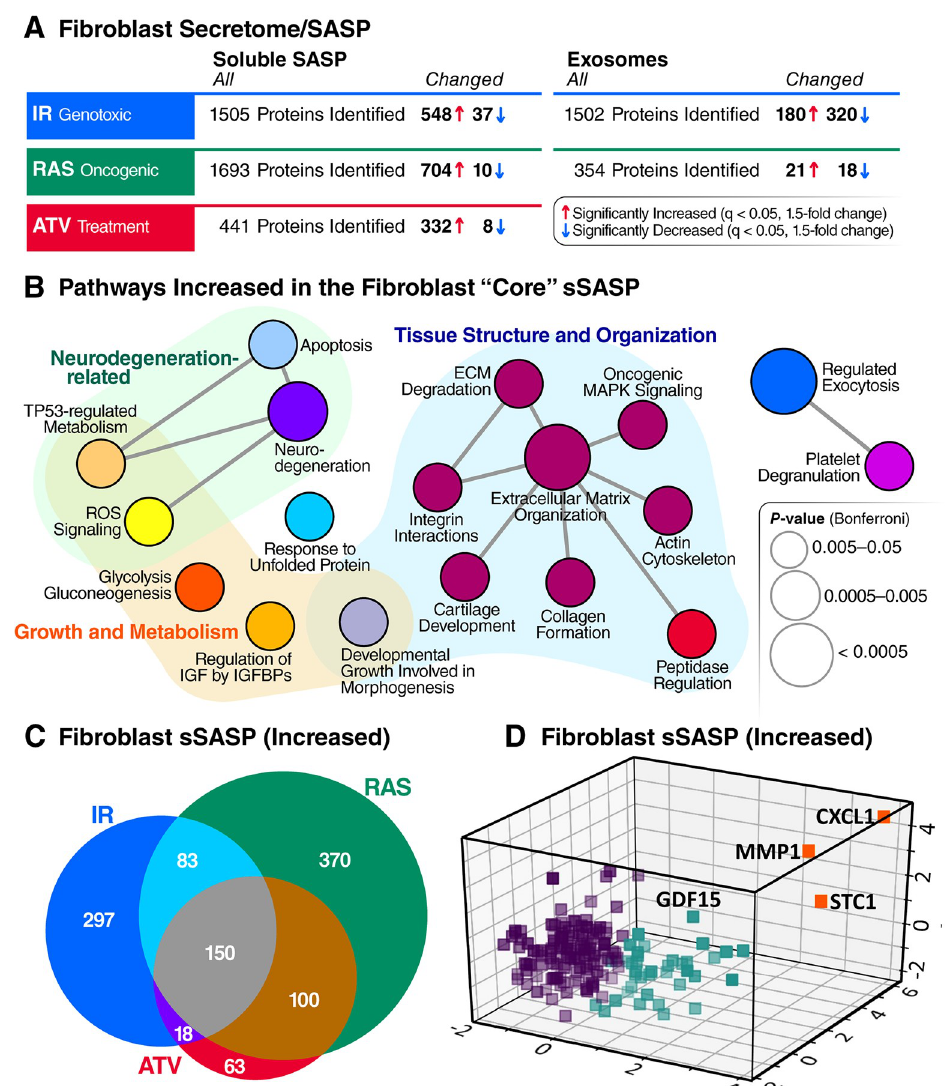
Fig 2. Core sSASP proteins, networks and pathways. (A) Summary of proteins with significantly altered (q-value < 0.05 and > 1.5-fold change) secretion by senescent compared with quiescent cells following genotoxic, oncogenic, or ATV treatment stress in senescent human lung fibroblasts. (B) ClueGO [33] pathway enrichment and network analyses of overlapping sSASPs resulting from each senescence inducer. Pathways of the same color have � 50% similarity. Connecting lines represent Kappa connectivity scores > 40%. (C) Venn diagram of proteins showing significantly increased secretion in senescent versus non-senescent fibroblasts following induction of senescence by IR, RAS, or ATV. (D) Unsupervised K-means clustering of proteins significantly increased in the sSASPs of all inducers based on the magnitude of the protein changes (log2-fold change) in senescent versus control groups and partitioned into three clusters. ATV, atazanavir treatment; CXCL1, chemokine C-X-C motif ligand 1; ECM, extracellular matrix; GDF15, growth/differentiation factor 15; IGF, insulin-like growth factor; IGFBP, IGF binding protein; IR, X- irradiation; MMP1, matrix metalloproteinase-1; RAS, RAS oncogene overexpression; ROS, reactive oxygen species; sSASP, soluble senescence-associated secretory phenotype; STC1, stanniocalcin 1; TP53, tumor protein p53. proteins identified in fibroblasts were either decreased or unchanged, except for IGFBPs 2/3 and CXCL8. This finding suggests that fibroblast SASP markers do not necessarily pertain to other cell types. Similarly, within exosomes/EVs secreted by senescent fibroblasts, several pre- viously identified key SASP factors were either absent, unchanged, or decreased, including